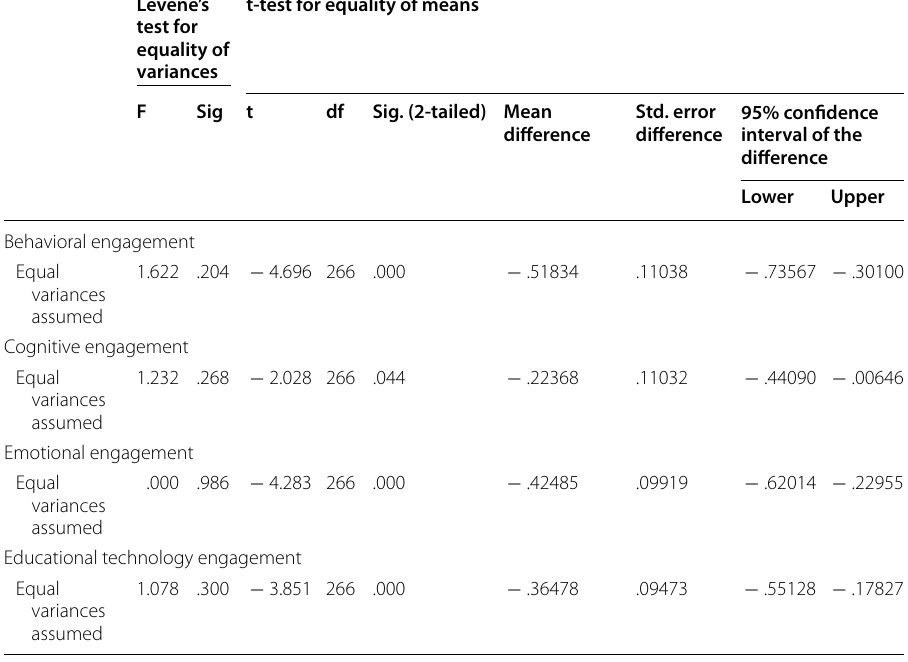
Table 7 Independent samples test of three dimensions of engagement and educational technology engagement